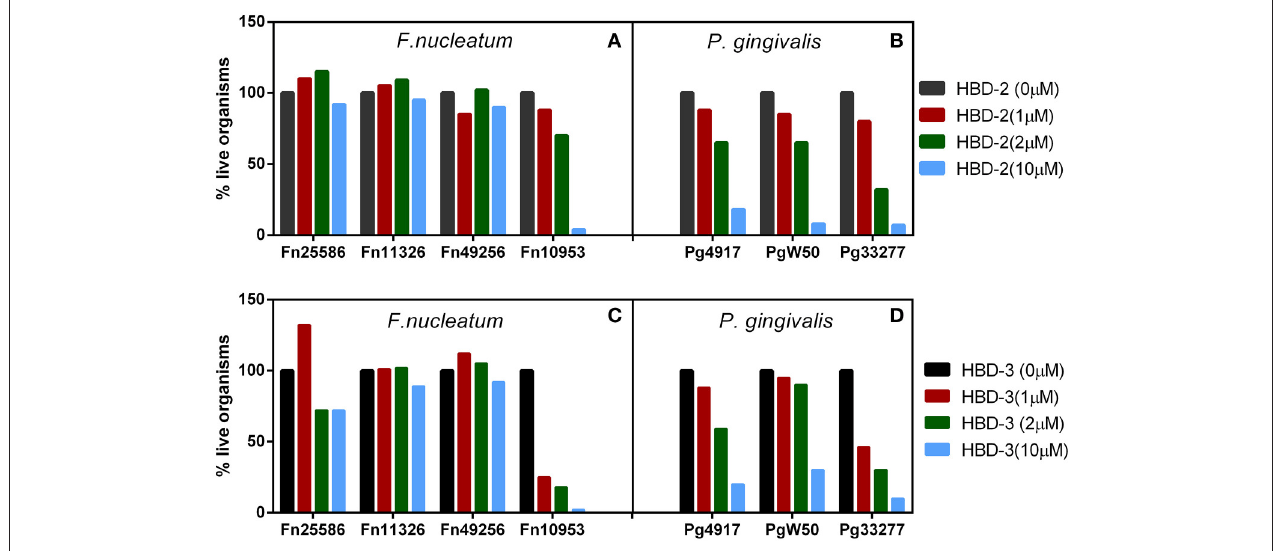
FIGURE 1 | (A–D) Representative F. nucleatum (A,C) and P. gingivalis (B,D) susceptibility to hBD-2 (A,B) and − 3 (C,D) , 2 × 10 5 bacteria were incubated with recombinant hBD-2 and 3 (indicated micro-molar concentrations) anaerobically, for 3h, followed by serial dilutions and plating on sheep red blood agar